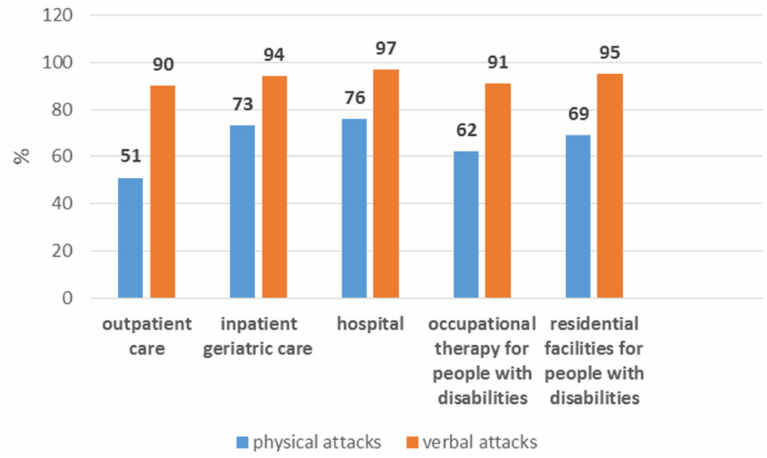
Figure 2. Frequency of physical and verbal attacks differ by workplace among employees who have experienced violence in the last 12 months.